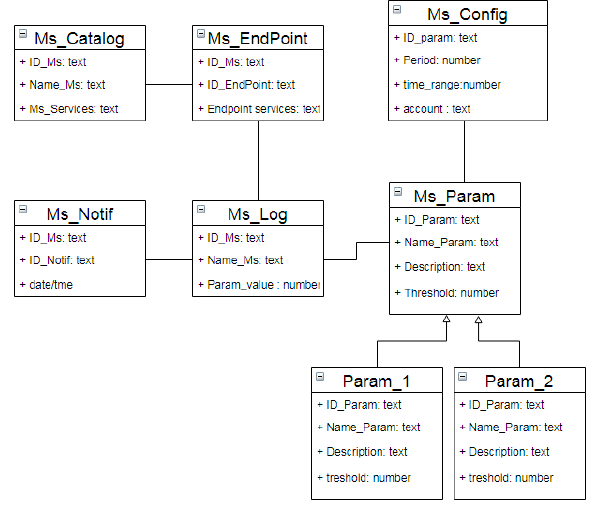
Figure 9. Class Diagram for DMM